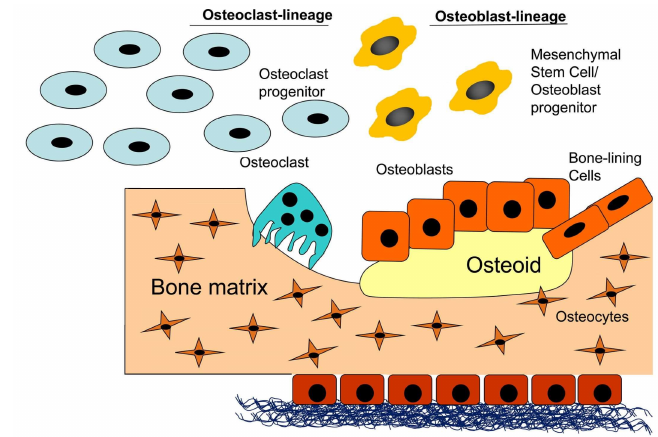
Figure 2. Matrix compartments of